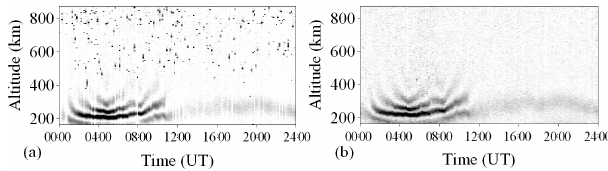
Figure 10. Diurnal variations of the IS signal power profile (a) be- fore SO selection and (b) after SO removal.